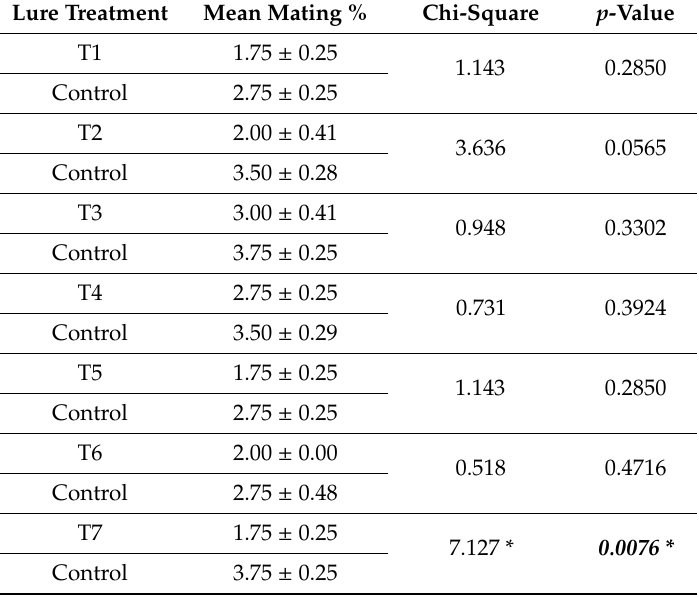
* indicates the level of significance at 5%: degree of freedom =